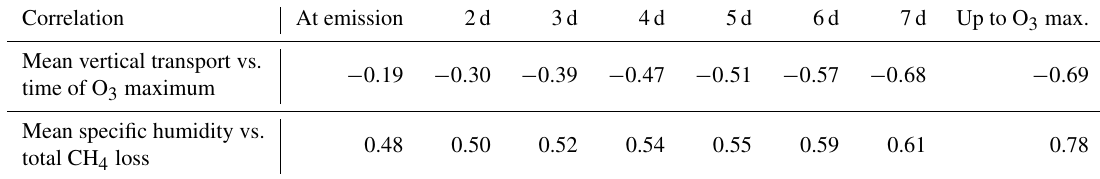
Table 3. Spearman rank coefficients for the correlation between the vertical transport and the time of the O 3 maximum and the specific humidity and the total CH 4 loss. Spearman rank coefficients are provided depending on the period used to calculate the mean value. The Spearman rank coefficient for each correlation for the period from the NO x emission until the O 3 maximum is also given. Correlation At emission 2d 3d 4d 5d 6d 7d Up to O 3 max. Mean vertical transport vs. − 0 . 19 − 0 . 30 − 0 . 39 − 0 . 47 − 0 . 51 − 0 . 57 − 0 . 68 − 0 . 69 time of O 3 maximum Mean specific humidity vs. 0.48 0.50 0.52 0.54 0.55 0.59 0.61 0.78 total CH 4